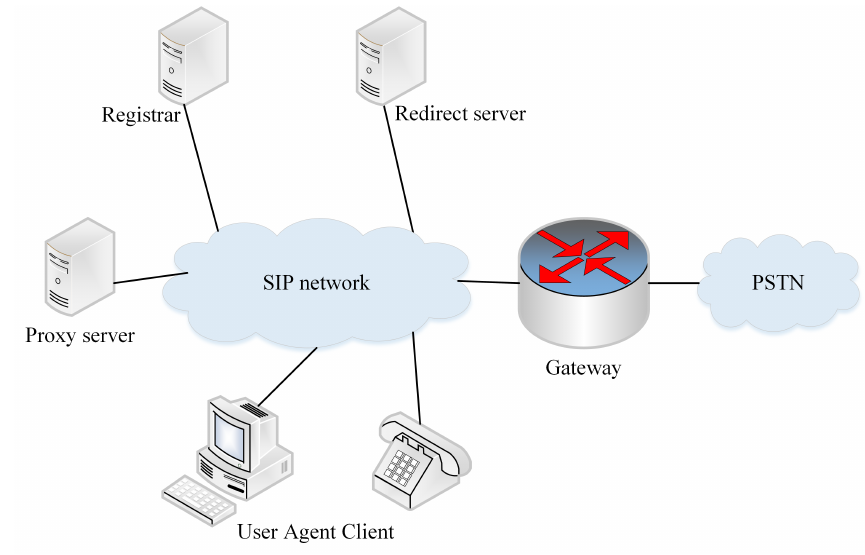
Figure 2. Main components of SIP architecture.